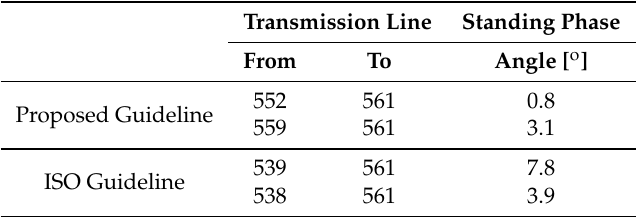
Table 1. Standing Phase Angles (SPAs) in the module for the transmission lines closed in each restoration